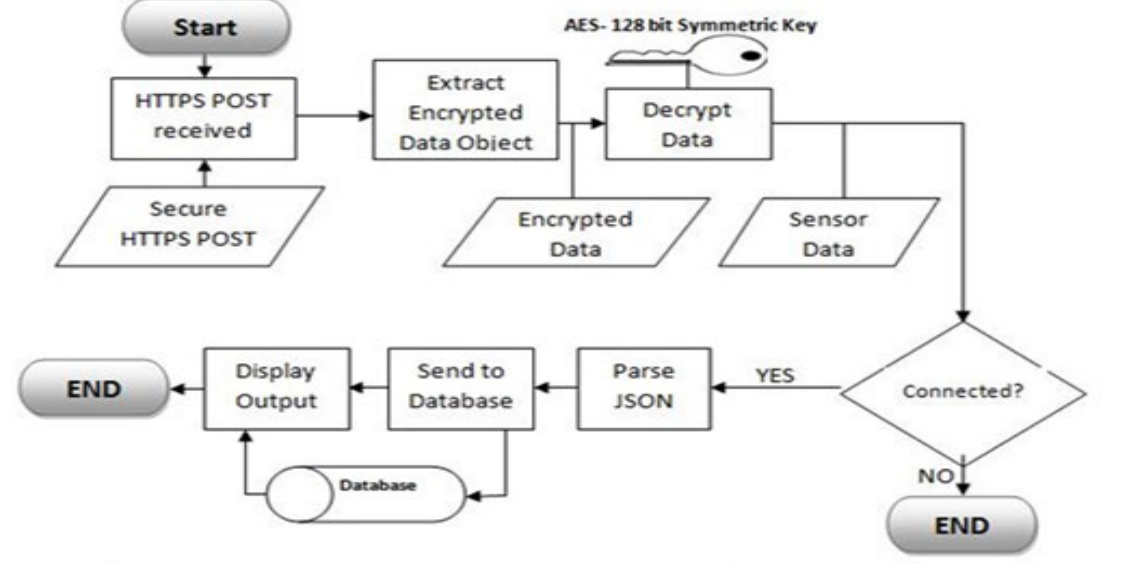
Figure 9. Block Diagram of Web